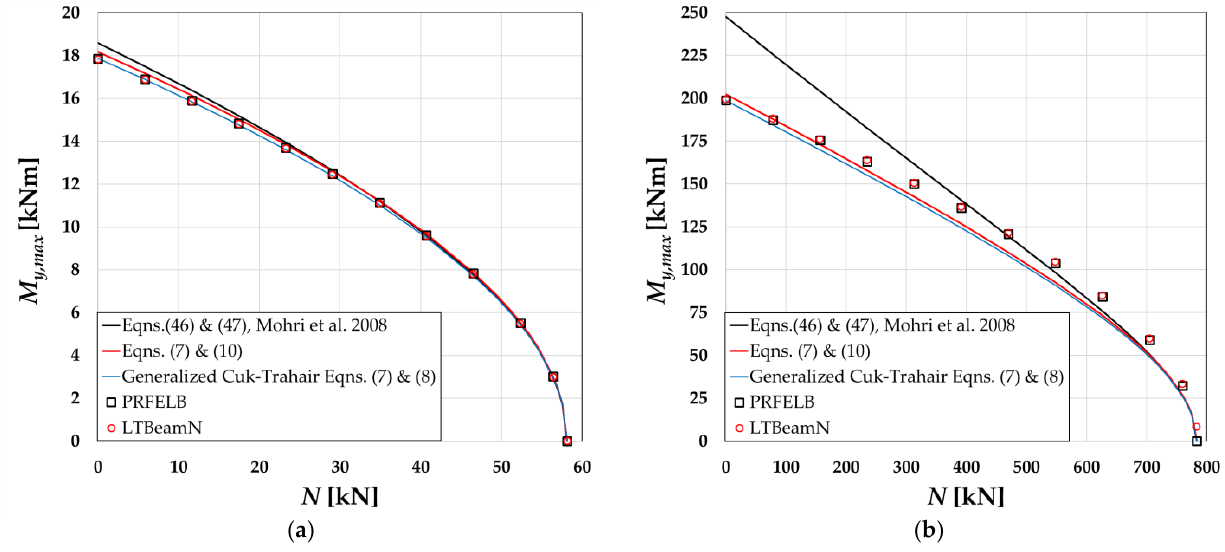
Figure 4. Verification of results from the present study with those of Mohri et al. [20] and computer programs LTBeamN and PRFELB for Case 1 of the in-plane loading system: ( a ) beam-column of section IPE 180; ( b ) beam-column of section HEB 180.